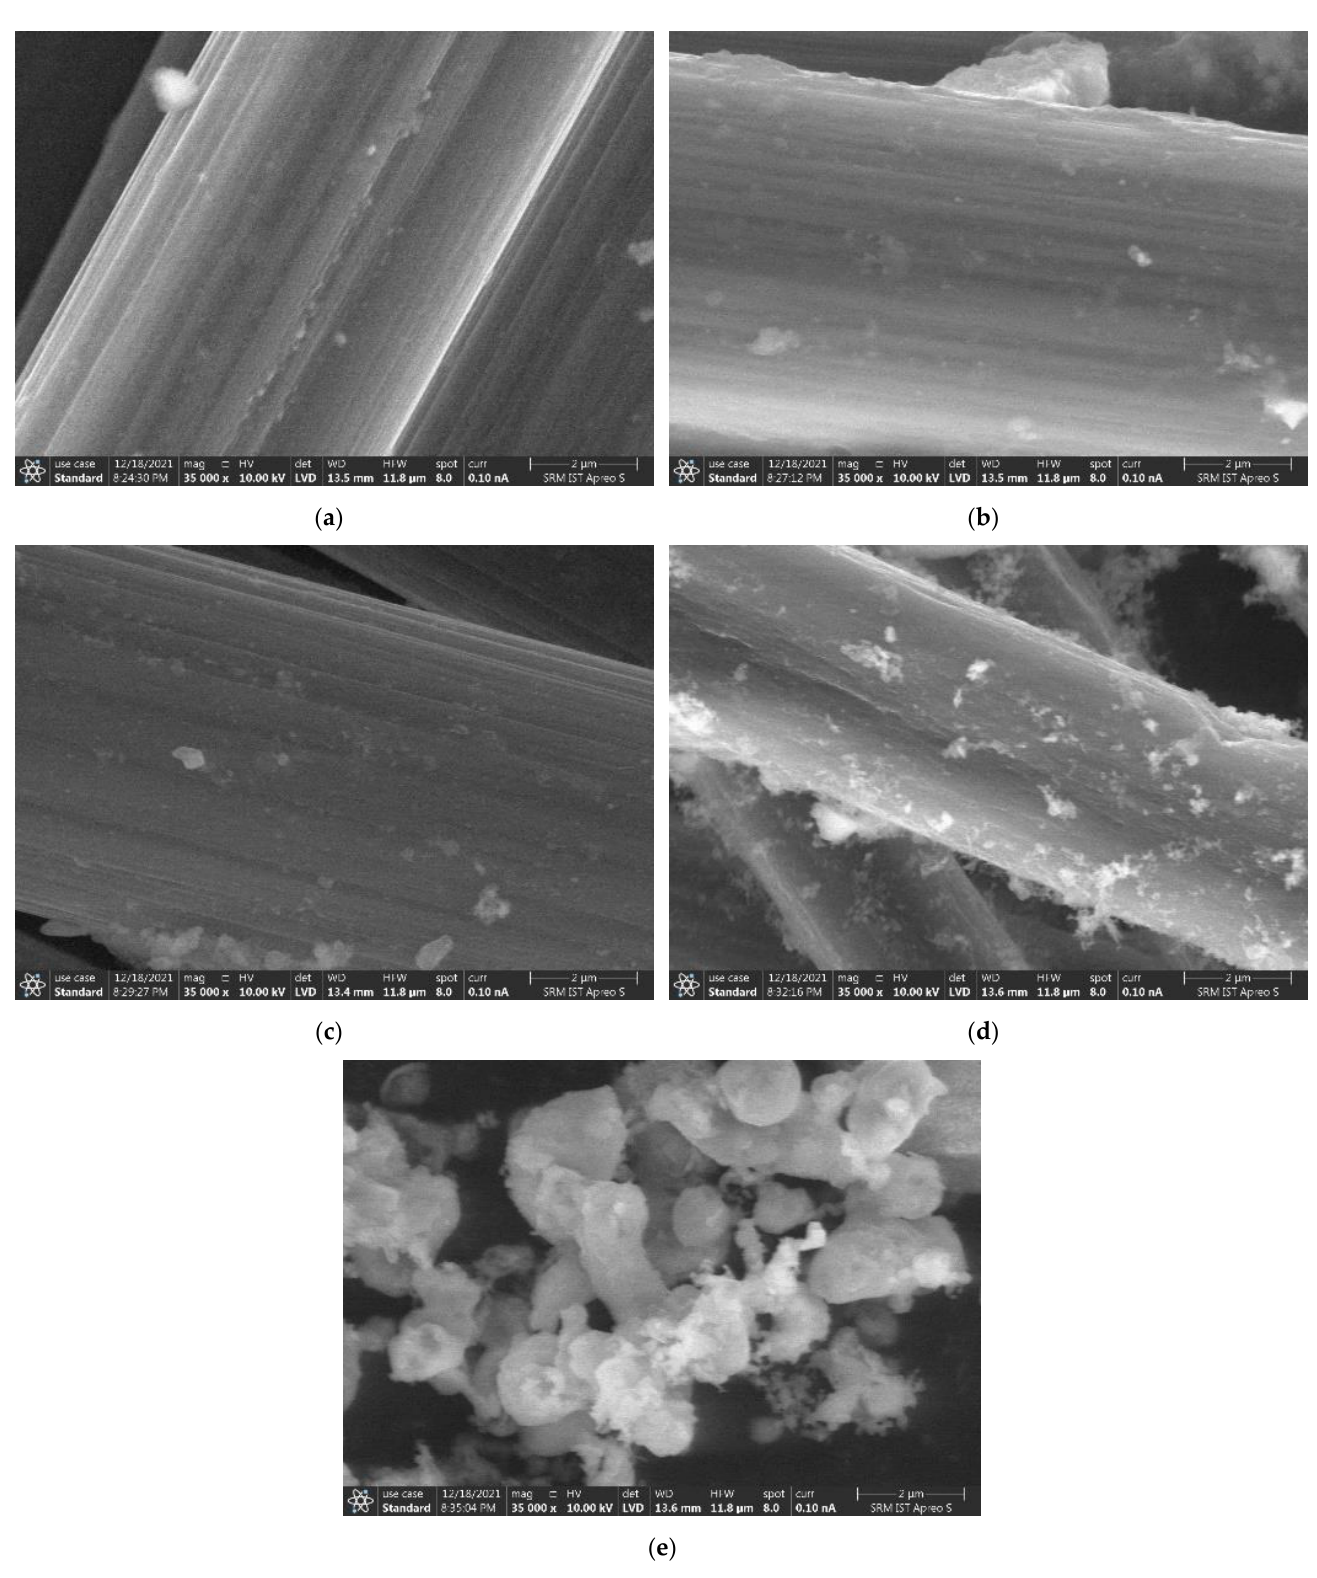
Figure 20. SEM Images of raw carbon fibre subjected to different temperatures. ( a ) Room temperature; ( b ) 200 °C; ( c ) 400 °C; ( d ) 600 °C; ( e ) 800 °C.